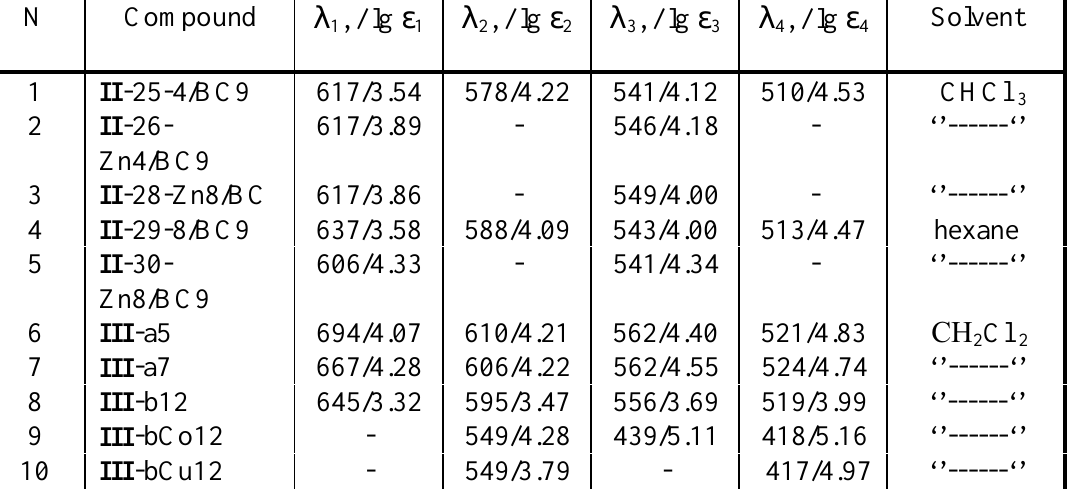
Table 5. Electronic absorption spectra of compounds II , III